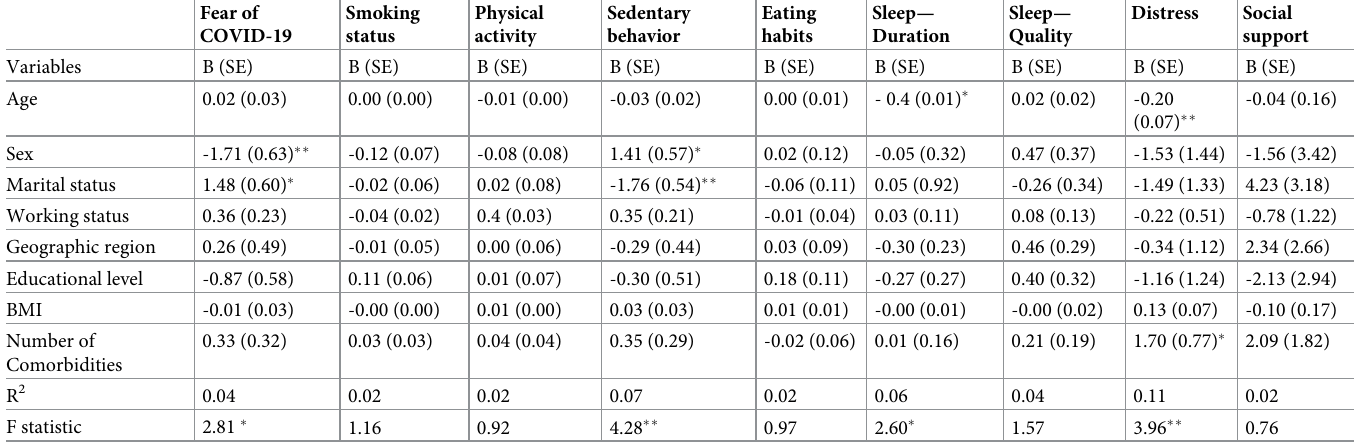
Table 4. The relationship between fear of COVID-19 (n = 276) and lifestyle behaviors with sociodemographic variables (age, sex, BMI, marital status, education level, working status, geographic region, and number of comorbidities).